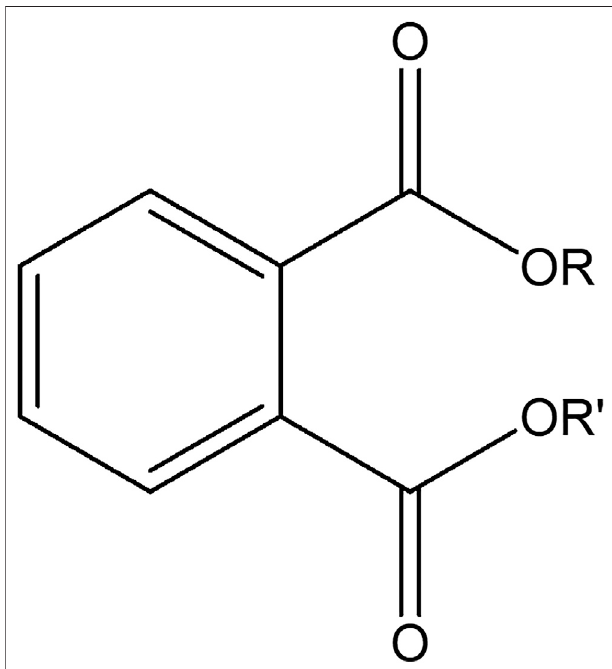
FIGURE 1 | General chemical structure of phthalate ester.